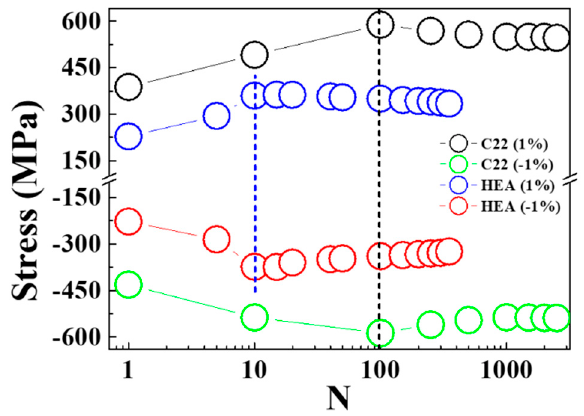
Figure 2. The stress evolution at the maximum tension (1%) and compression ( − 1%) as a function of fatigue cycle (presented in log scale) for both the C22™ and CoCrFeMnNi alloys.